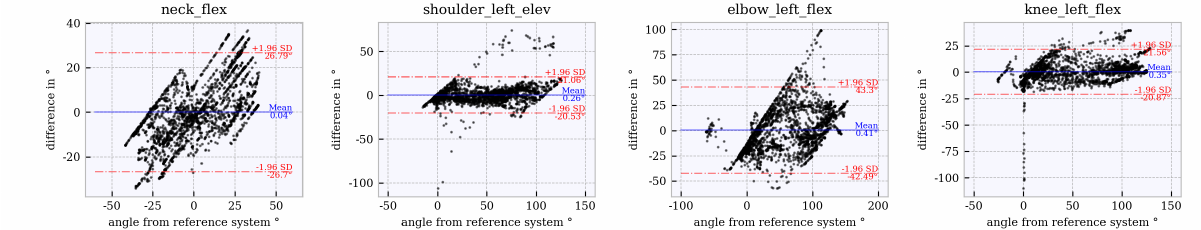
Figure 15. Bland–Altman plot for tracker configuration 8 ; x does not show the average of both systems but the joint angles of the reference system,